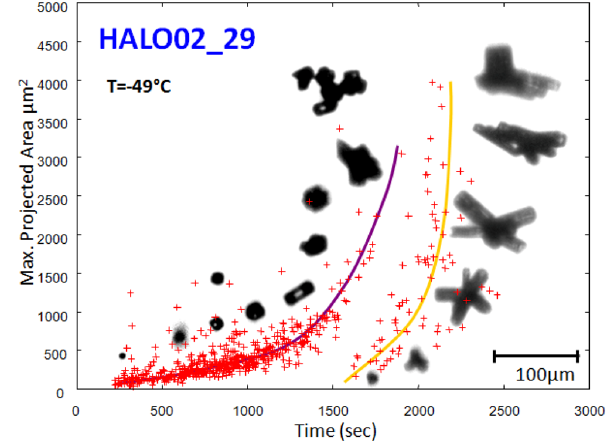
Fig. 14. Different ice nucleation paths depicted by PHIPS during Figure 14. Different ice nucleation paths depicted by PHIPS during an AIDA expansion 3 an AIDA expansion (HALO02 29 at − 49 ◦ C). The lines are just for (HALO02_29 at -49°C). The lines are just for guidance to indicate two distinct nucleation and 4 guidance to indicate two distinct nucleation and growth growth events. 5